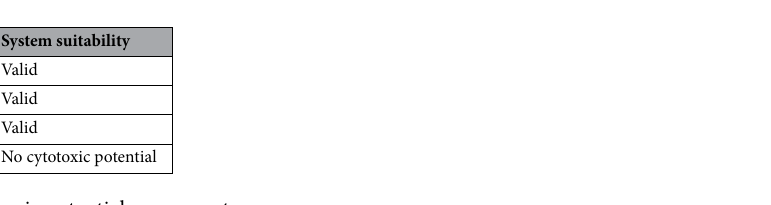
Table 3. Results of cytotoxic potential